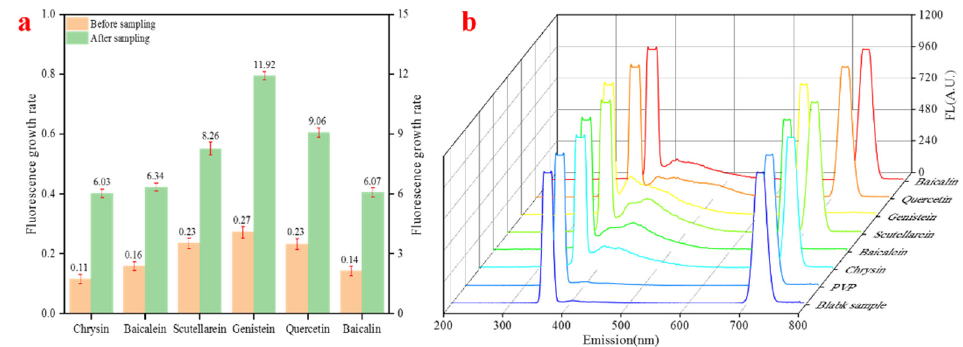
Figure 7 . Fluorescence and fluorescence enhancement in the active molecular membrane trap cham- ber after simulated O 3 radical reaction ( a ) Fluorescence enhancement graph, ( b ) Fluorescence spec- trum trum graph.